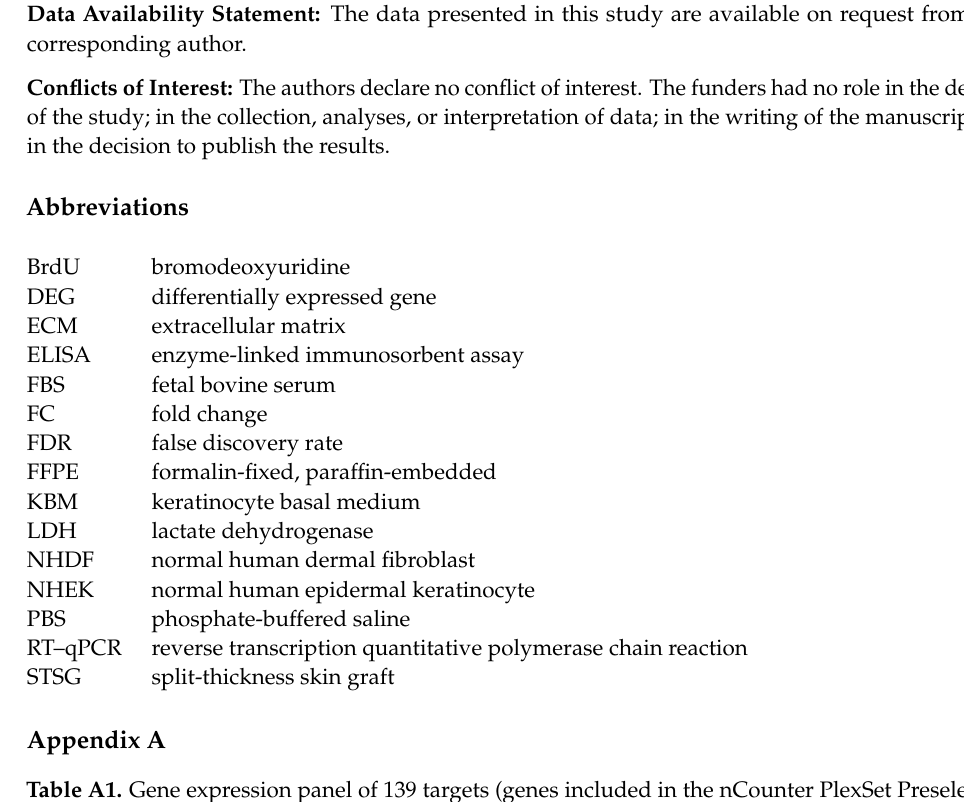
Table A1. Gene expression panel of 139 targets (genes included in the nCounter PlexSet Preselected Human Wound Healing Panel arehighlighted in